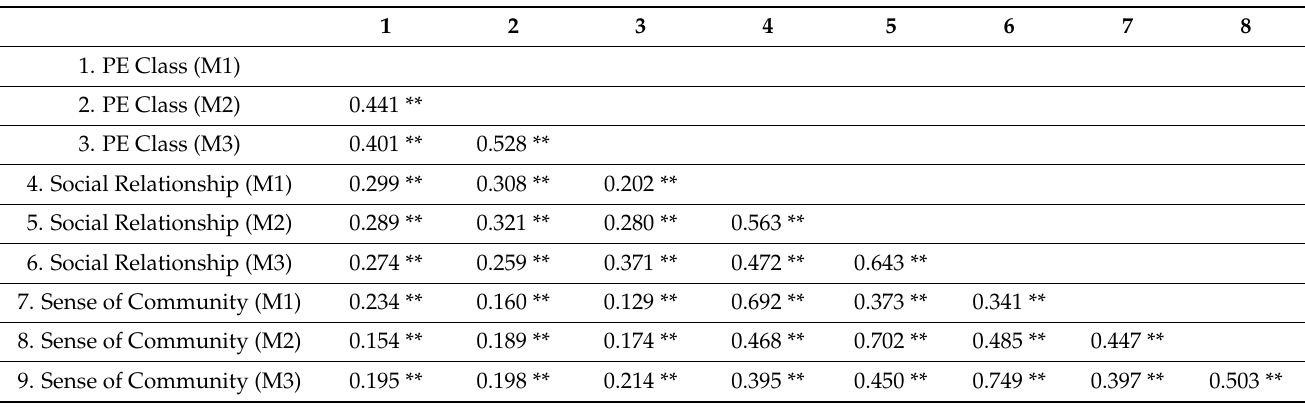
Table 2. Correlations among the main variables.